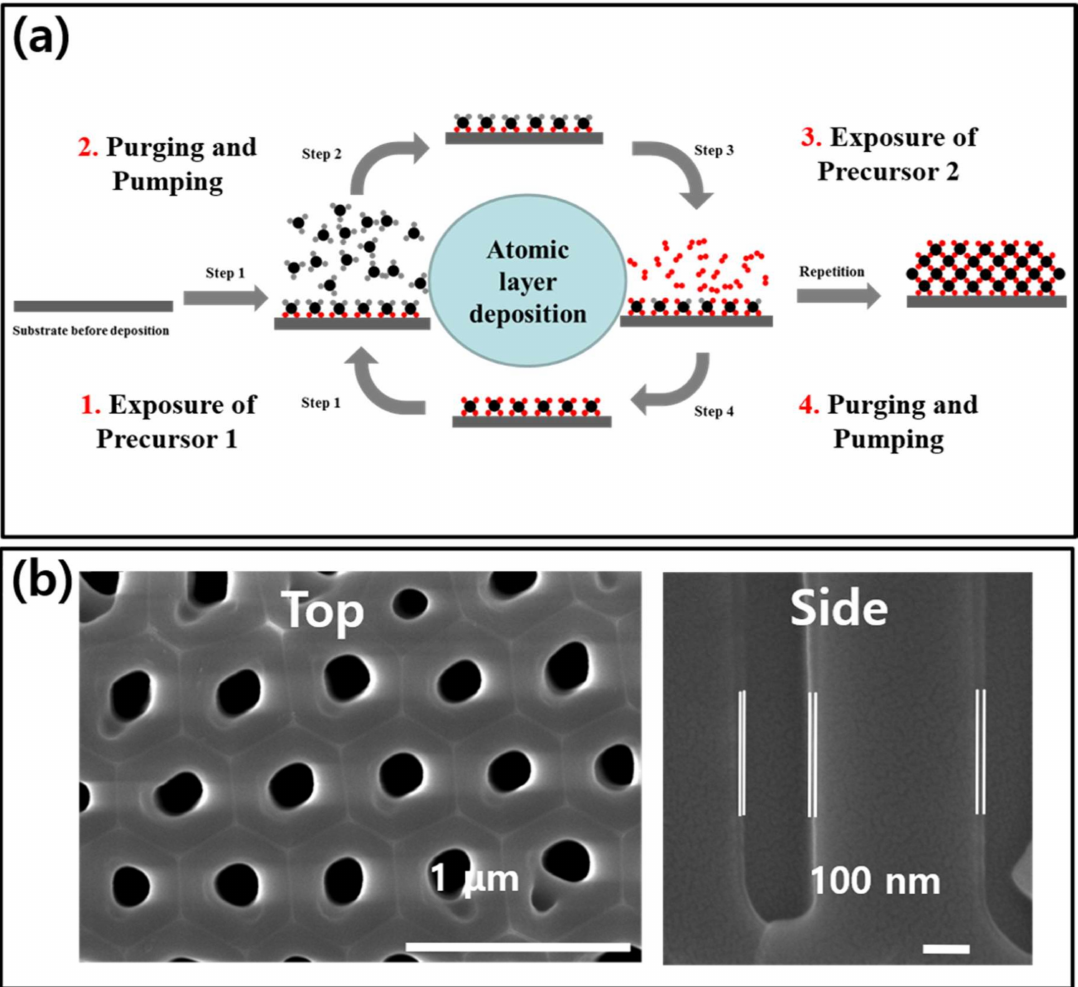
Figure 1. ( a ) The operating principle of atomic layer deposition is schematically described. ( b ) Scanning Electron Microscopy (SEM) images of TiO 2 thin films on anodic aluminum oxide substrates deposited using atomic layer deposition (ALD). Edited from Reference